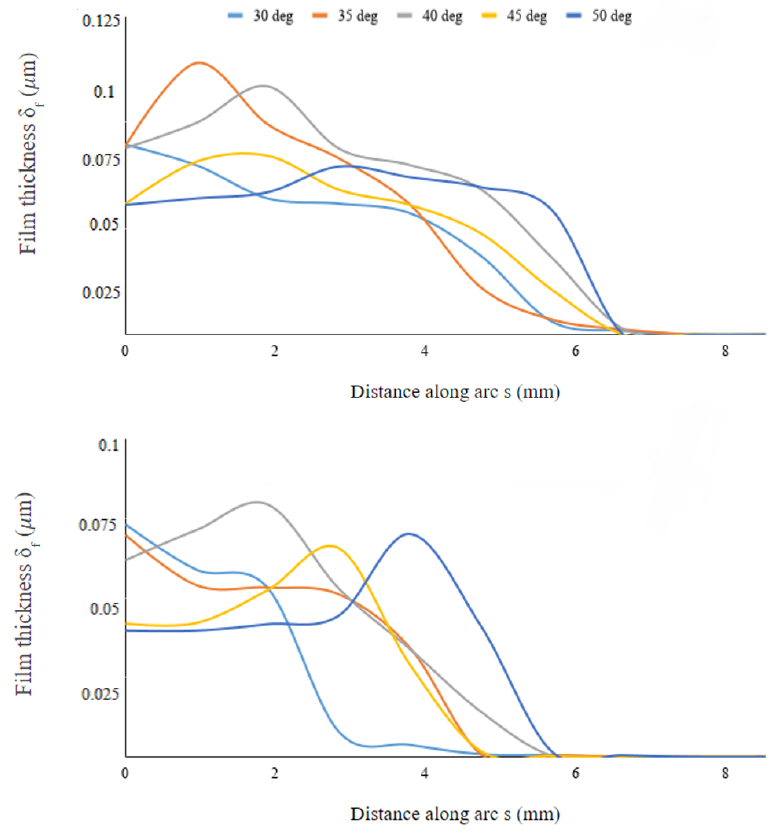
Figure 11. Water film thickness along selected arcs on the body’s surface and at various body inclination angles (runs A4–A8). Top panel: arc cutting through the lengthwise vertical symmetry plane of the semi-ellipsoid; Bottom panel: arc defined by the intersection of the body and an inclined plane passing through the lengthwise symmetry line at the bottom surface and turned 45 deg from the vertical symmetry